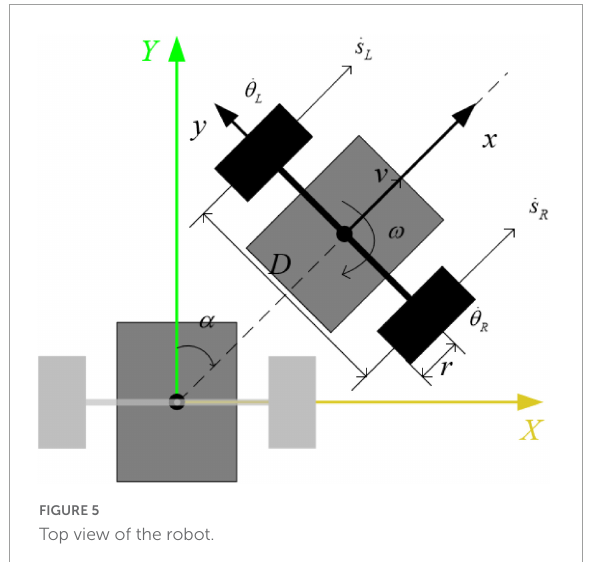
FIGURE5 Top view of the robot.